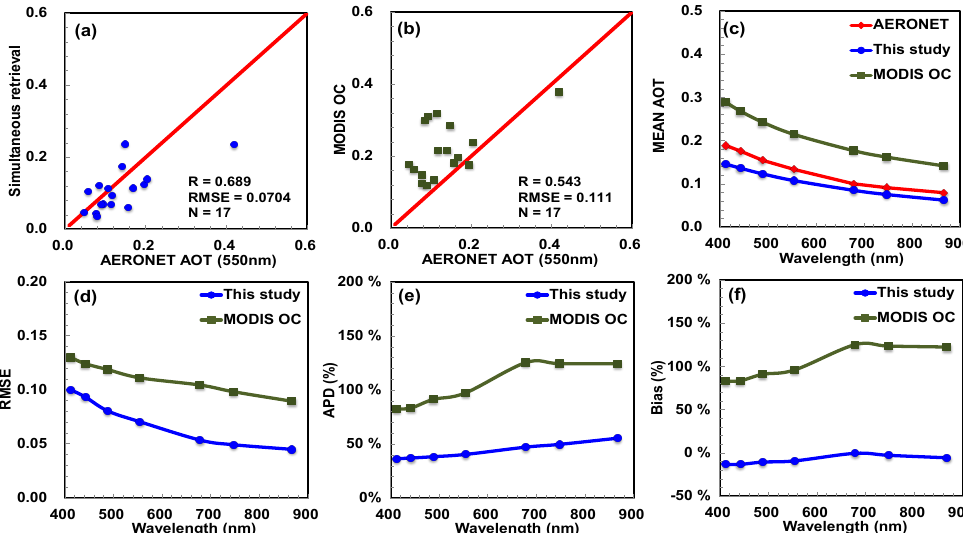
Figure 10. Similar to Fig. 6 but using the satellite measurements covered in sunglint.